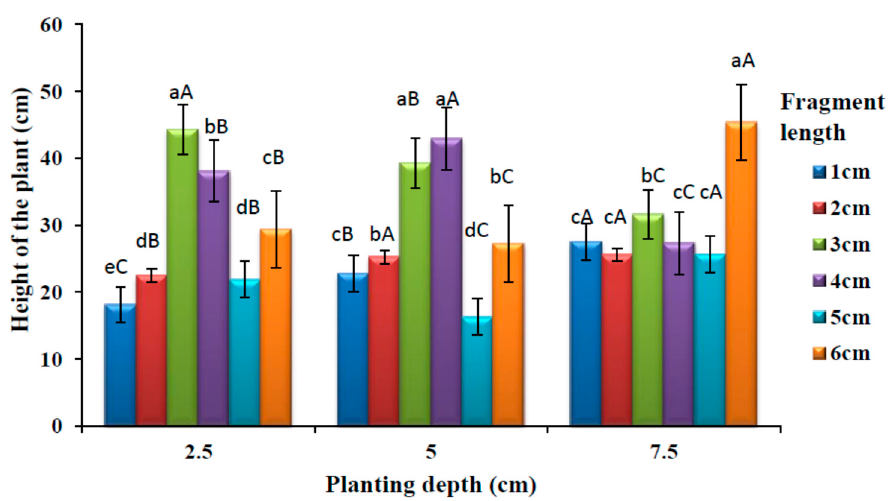
Figure 5. Effects of planting depths and rhizome lengths on the plant height. Bars with different lowercase superscripts (a > b > c > d > e) in the same groups of planting depth are significantly different ( p < 0.05) while bars with different uppercase superscripts (A > B > C) within a fragment length in the